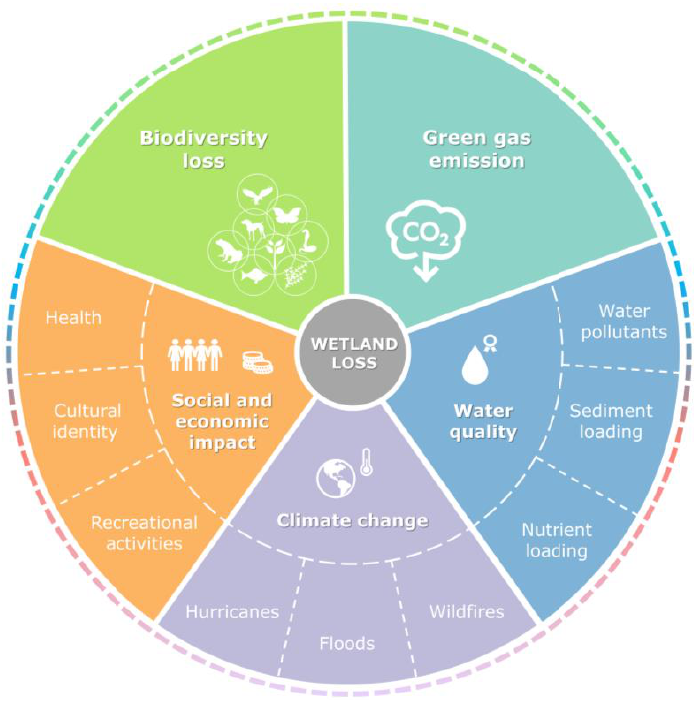
Figure 1. Ecological and socioeconomic impacts of wetland loss.